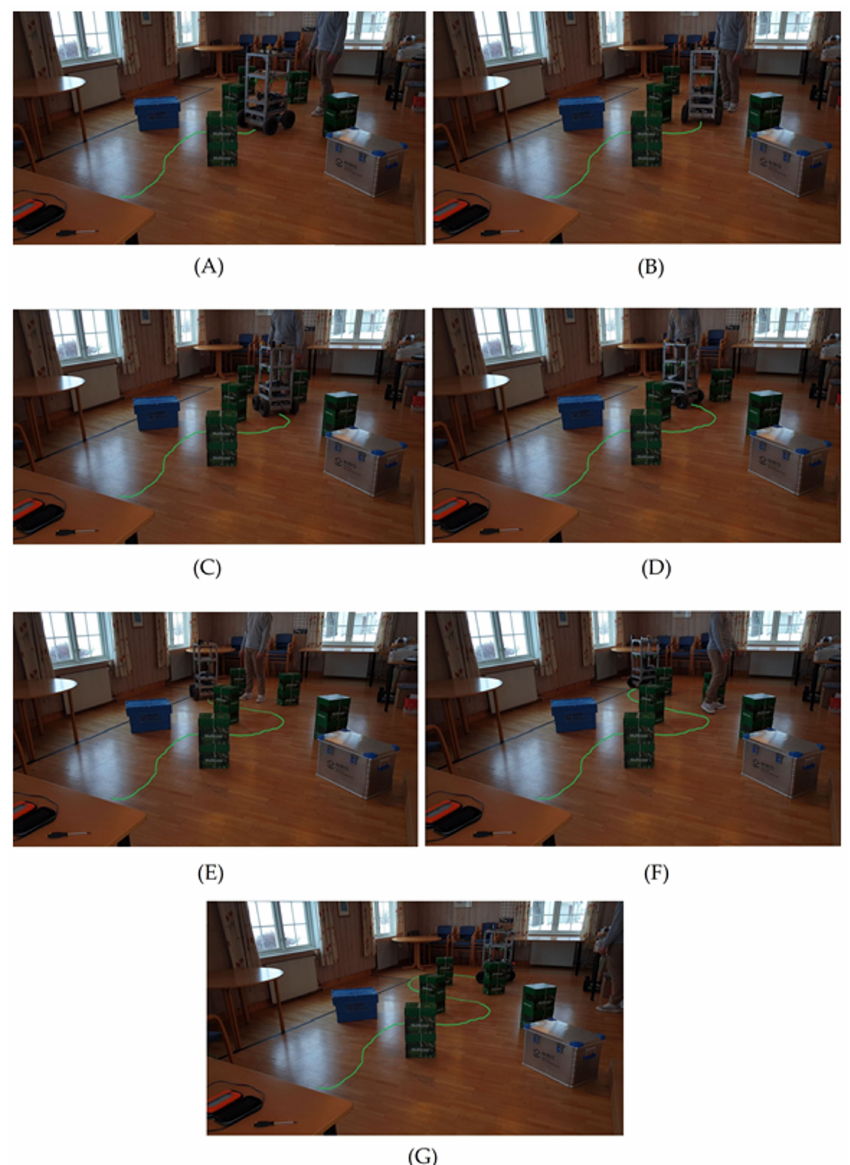
Figure 16. Experimental results showing static and dynamic obstacle avoidance. In ( A ), the human enters the scene and keeps obstructing the robot’s path ( B – D ). In ( E ), the human stops obstructing the path and leaves the scene in ( F ). In ( G ), the robot is parked at its final destination. The virtual overlaid green line on the ground represents the path of the